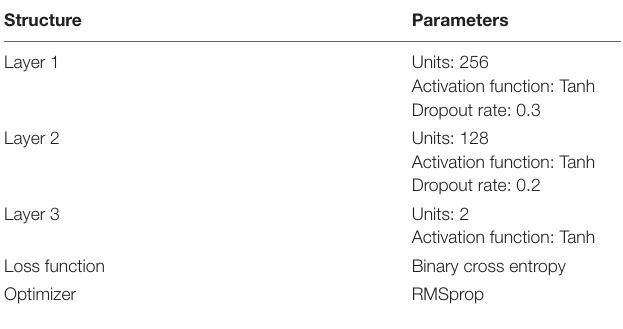
TABLE 1 | The parameters of DNN